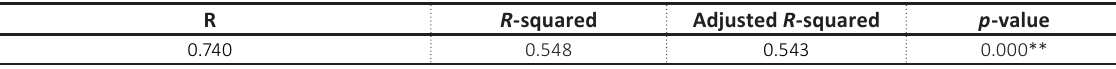
Table 18. Summary of adjusted R